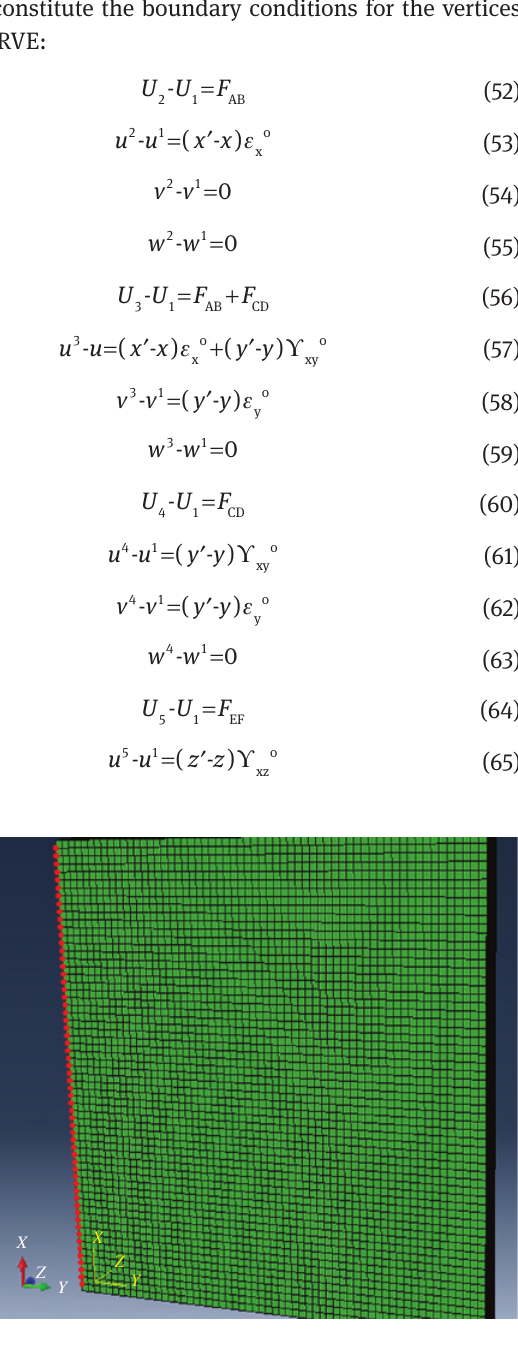
Figure 12: Constrained nodes on an edge.